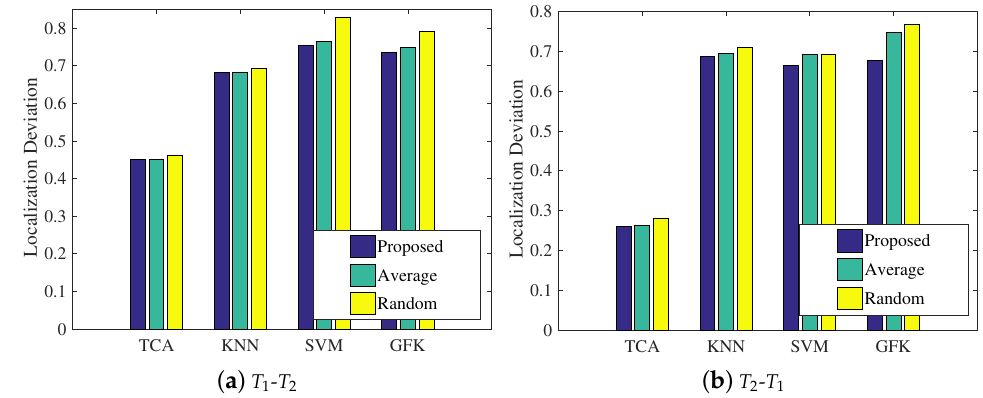
Figure 17. Impact of the weighted coefficient on localization performance in the